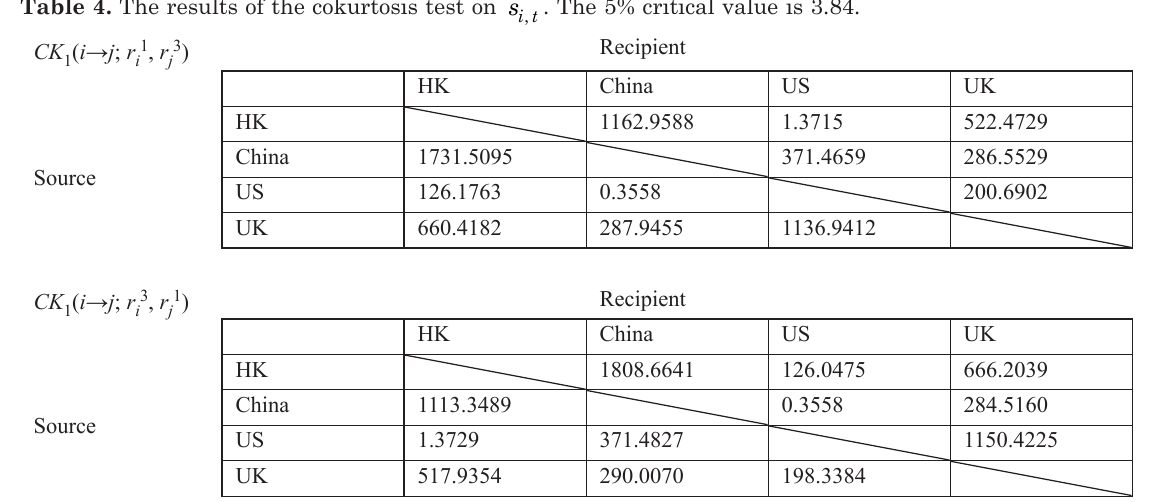
table 4. the results of the cokurtosis test on